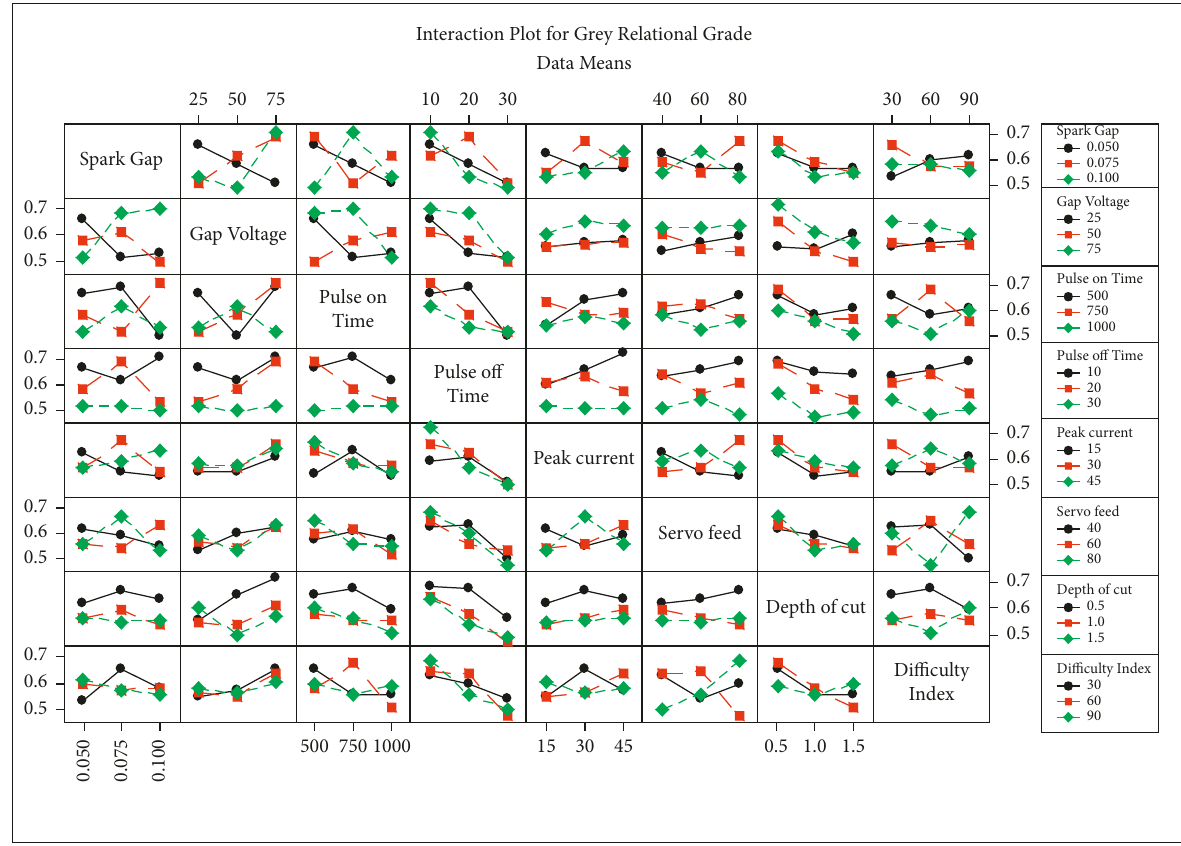
Figure 9: Interaction plot for overall grey relational grade (OGRG).